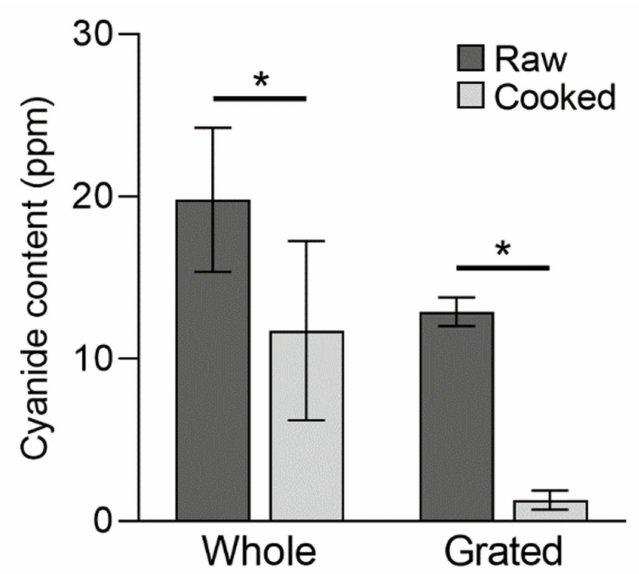
Figure 2. Total cyanide content of whole root ( n = 12) and grated ( n = 6) frozen cassava products when raw and cooked, measured using the evolved cyanide method. Values are means ± SEM. Asterisks indicate significant differences ( p < 0.05) in cyanide content before and after